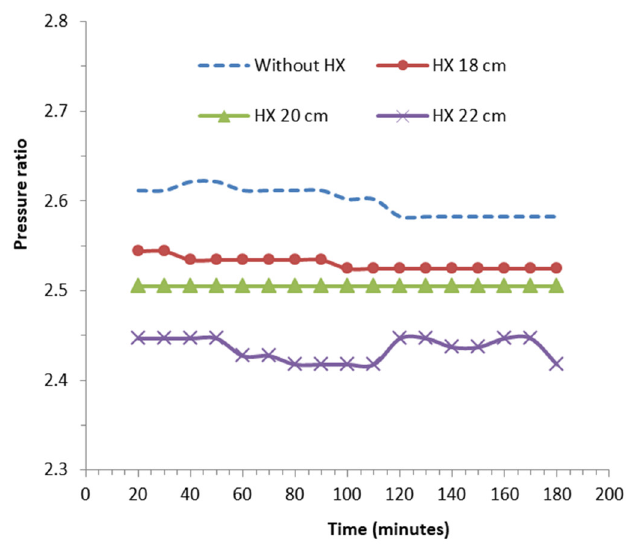
Figure 9. Pressure ratio of the air conditioner for four different cases.